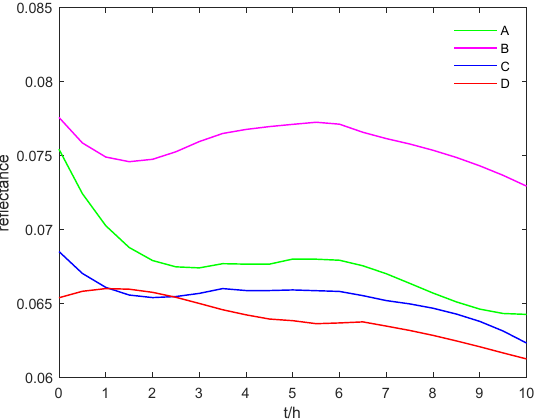
Figure 11. Curves of the average spectra of different grade seeds with germination time.